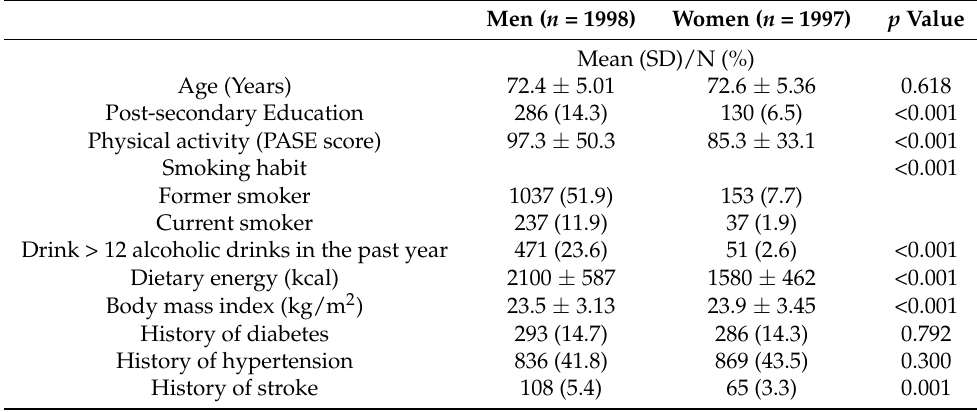
Table 1. Baseline characteristics of participants in the Mr. OS and Ms. OS